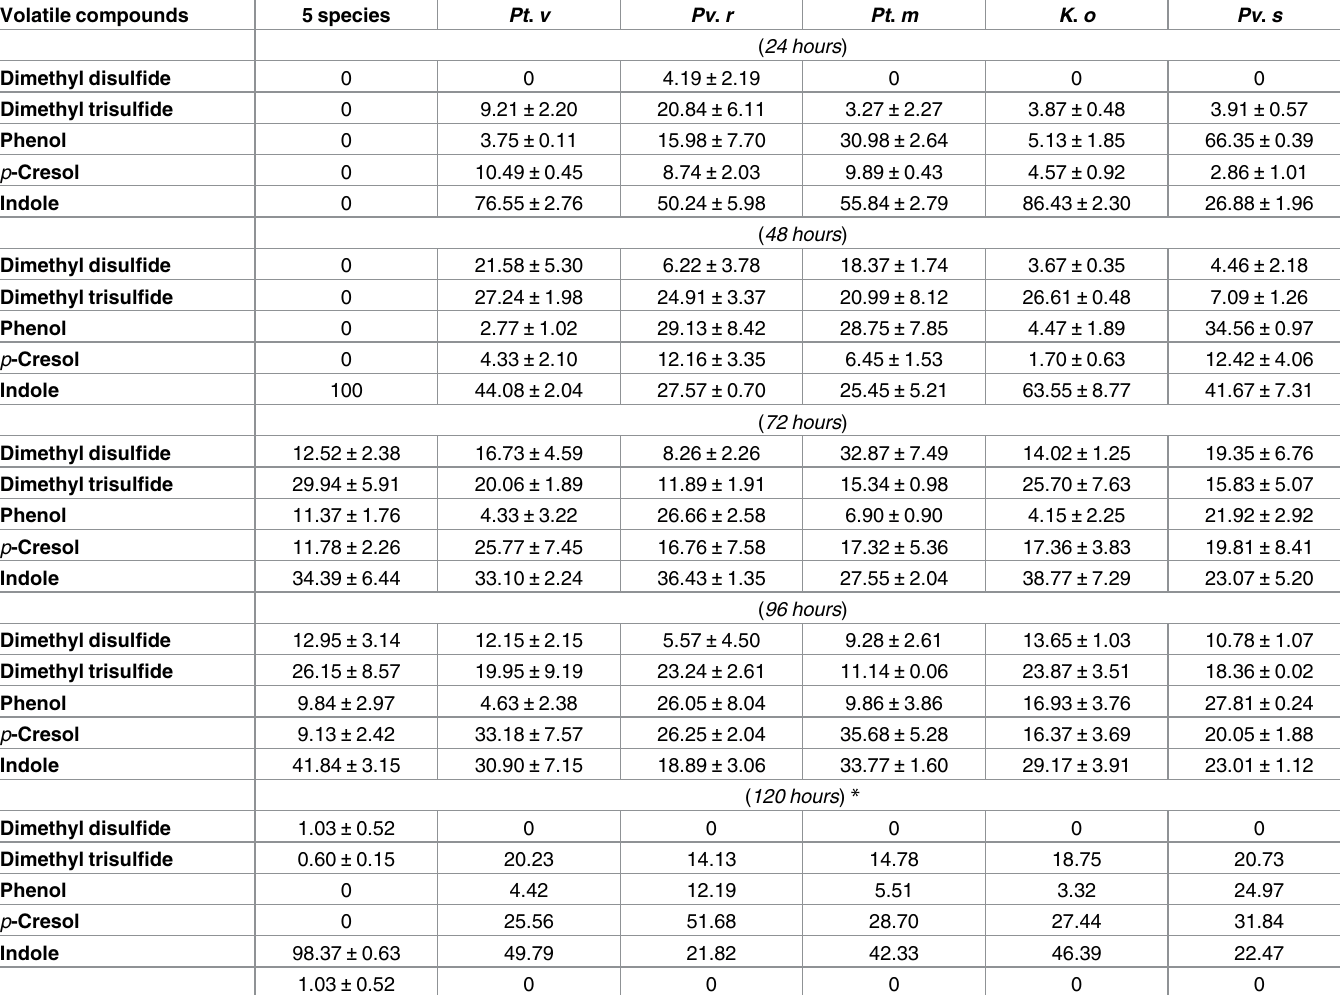
Table 2. Relative ratios of solid phase microextraction absorption (SPME) of volatile compounds releasedfrom the combined and individual five bacteria in blood at different incubation times (1–5 days). Volatile